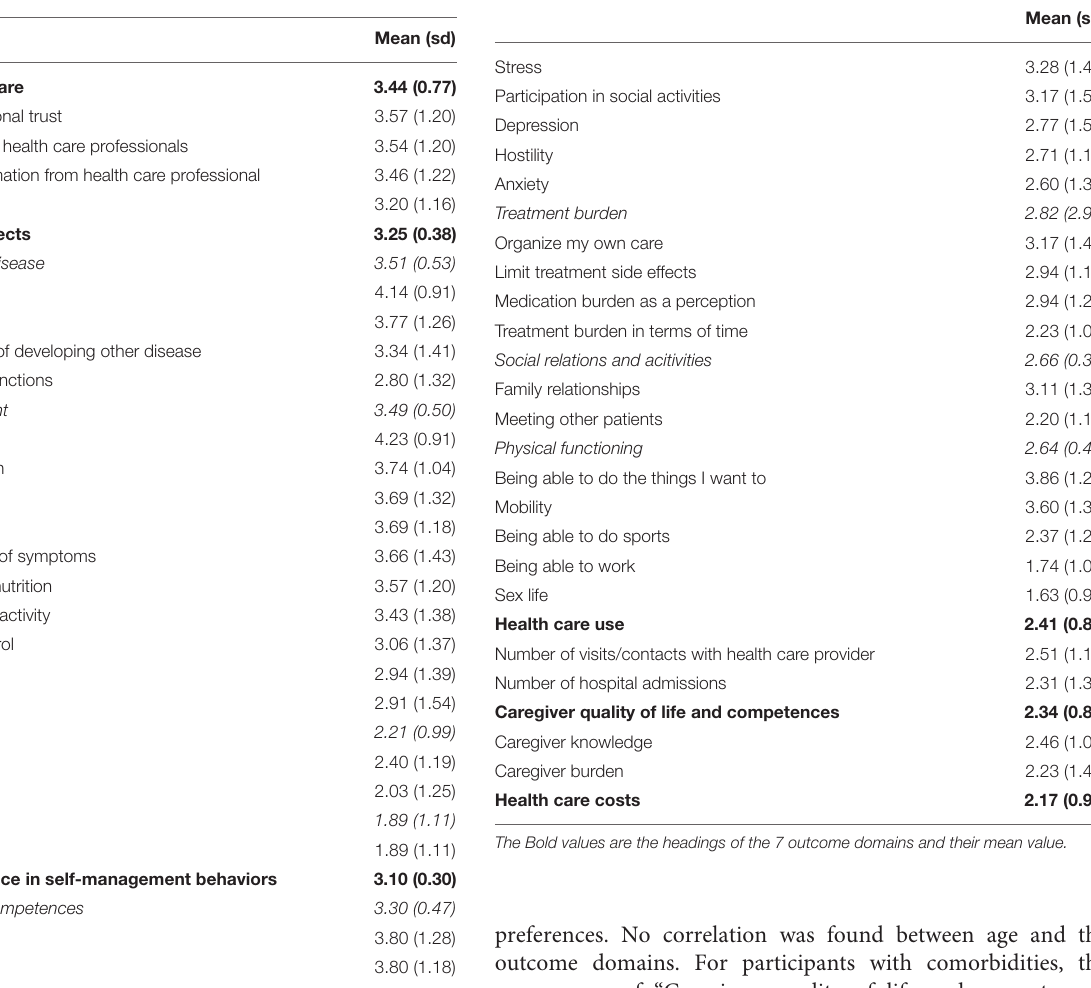
TABLE 2 | Mean importance scores of the seven outcome domains and their